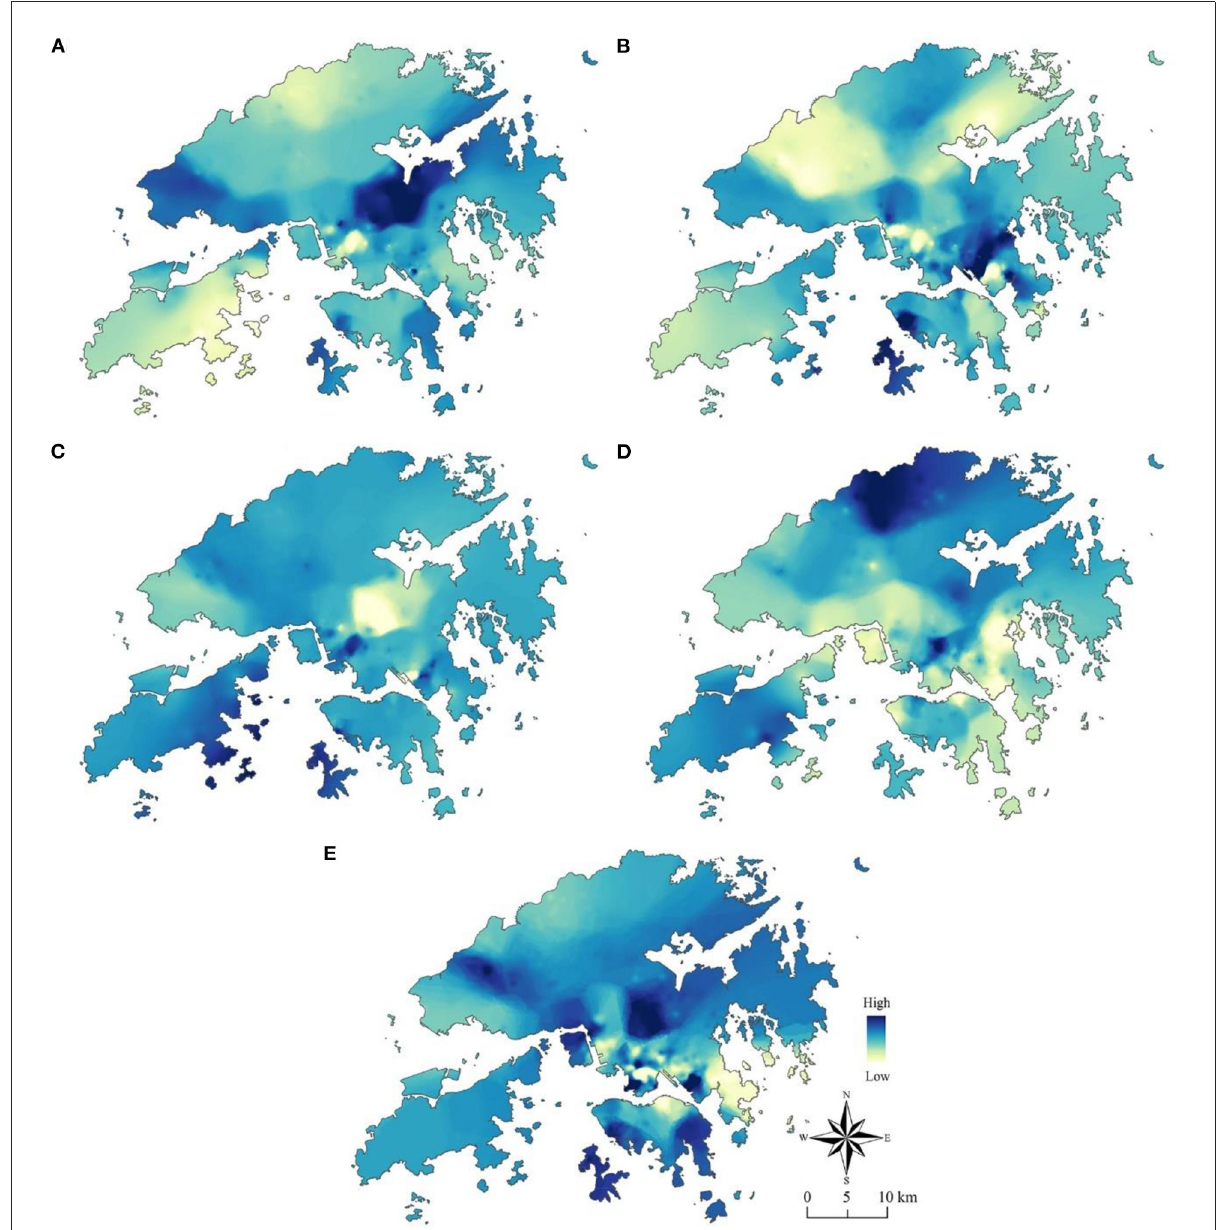
FIGURE7 The spatial distribution of the coefficients of the built environment variables. (A) Coefficient of population density. (B) Coefficient of land-use mix. (C) Coefficient of intersection density. (D) Coefficient of access to bus stops. (E) Coefficient of street